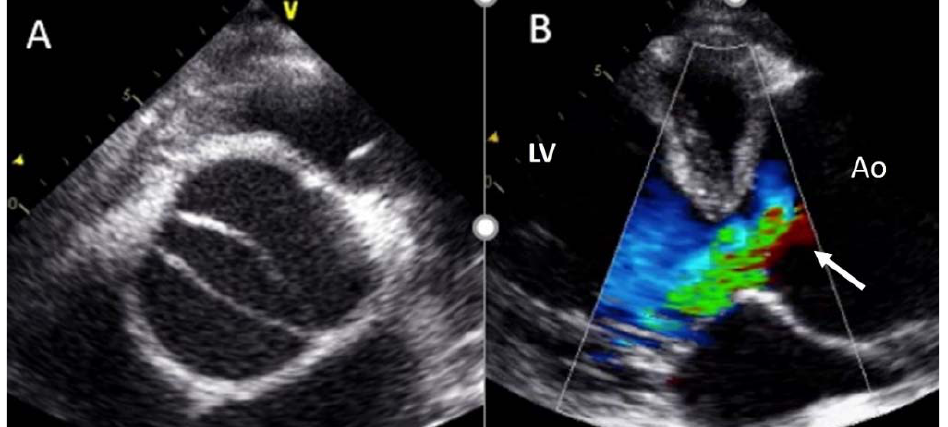
Figure 7. ( A ) BAV RC − LC sigmoid fusion in a patient with Marfan syndrome. ( B ) Severe aortic root dilation and severe aortic regurgitation (arrow). Ao—aortic root; LV— left ventricle.